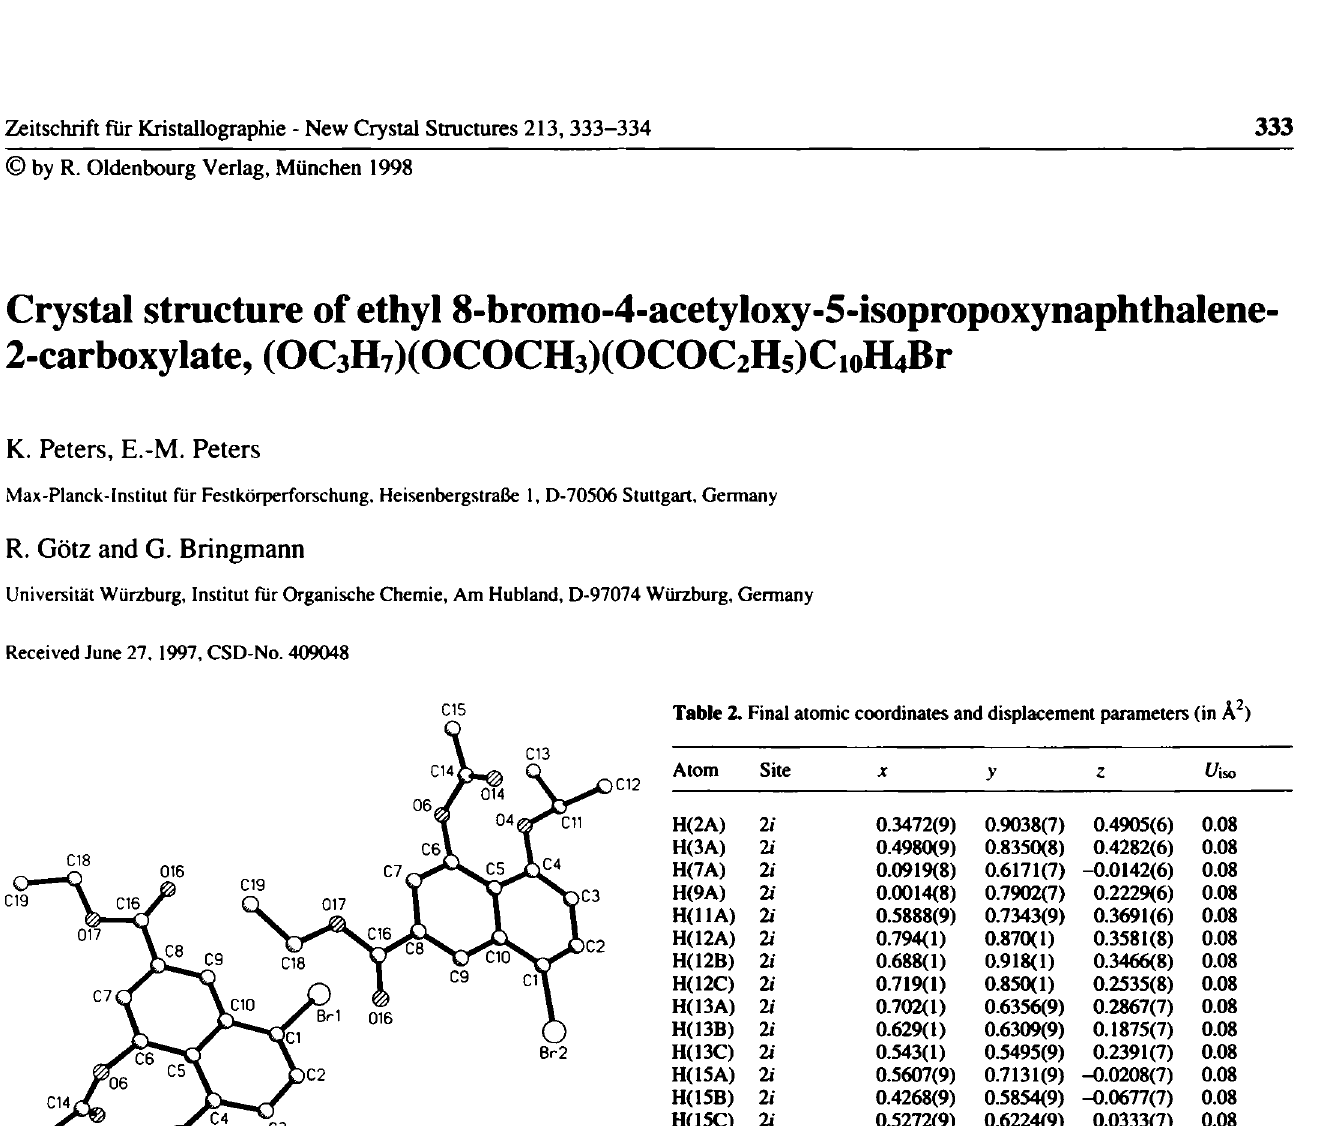
Table 2. Final atomic coordinates and displacement parameters (in